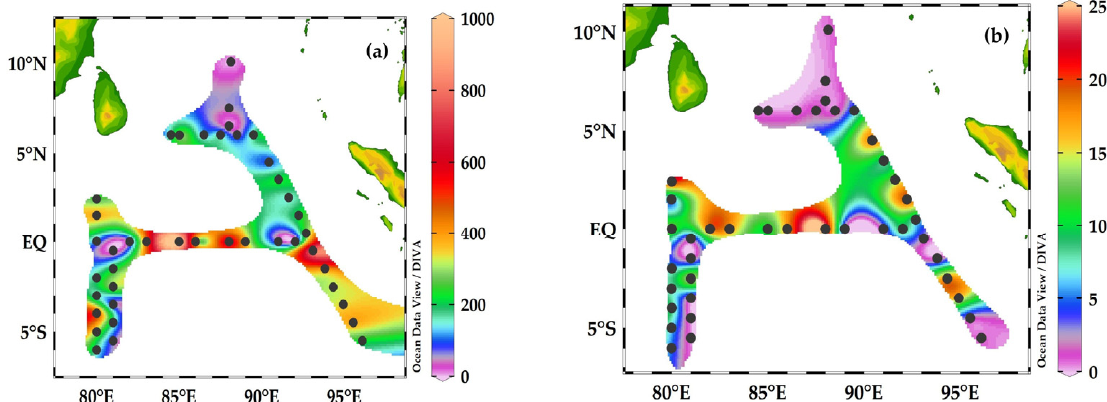
Figure 6. The abundance of ind.m − 3 ( a ) and carbon biomass µ g C m − 3 ( b ) of foraminifera in the Eastern Indian Ocean. ( a ) Foraminifera abundance was at a maximum at the equatorial region (EQ) and at a minimum in the BoB station at the transect 90 ◦ E. ( b ) The carbon biomass of foraminifera was also observed to be at a maximum in the equatorial region (EQ) compared to in the BoB sampling sites. The carbon biomass ranged from 0.06 to 25.5 µ g C m − 3 and high concentrations were recorded at stations I404, I406, and I409 in the equator zone, and low carbon biomass was recorded in the BoB at the transect 90 ◦ E (Figure 6b). The total contribution of foraminifera species to relative abundance, frequency distribu- tion, and dominant index is shown in (Table 1). The most dominant species are Globigerina bulloides and Globigerinoides ruber white with high contribution to total foraminifera be- tween 32 and 38%, followed by 20% of Orcadia riedeli , 18% of Globigerinella siphonifera and Turborotalita quinqueloba , and 12–10% of Globigerinella calida and Orbulina universa (Table 1). The high dominance as Y > 0.40 was recorded for G. bulloides , followed by Y > 0.14 of G. ruber (white) and Y > 0.039 of G. siphonifera whereas the low dominant index was recorded for G. scitula, Globorotalia tumida , G. ungulata , Tenuitella parkerae , T. fleisheri , and T. humilis ,